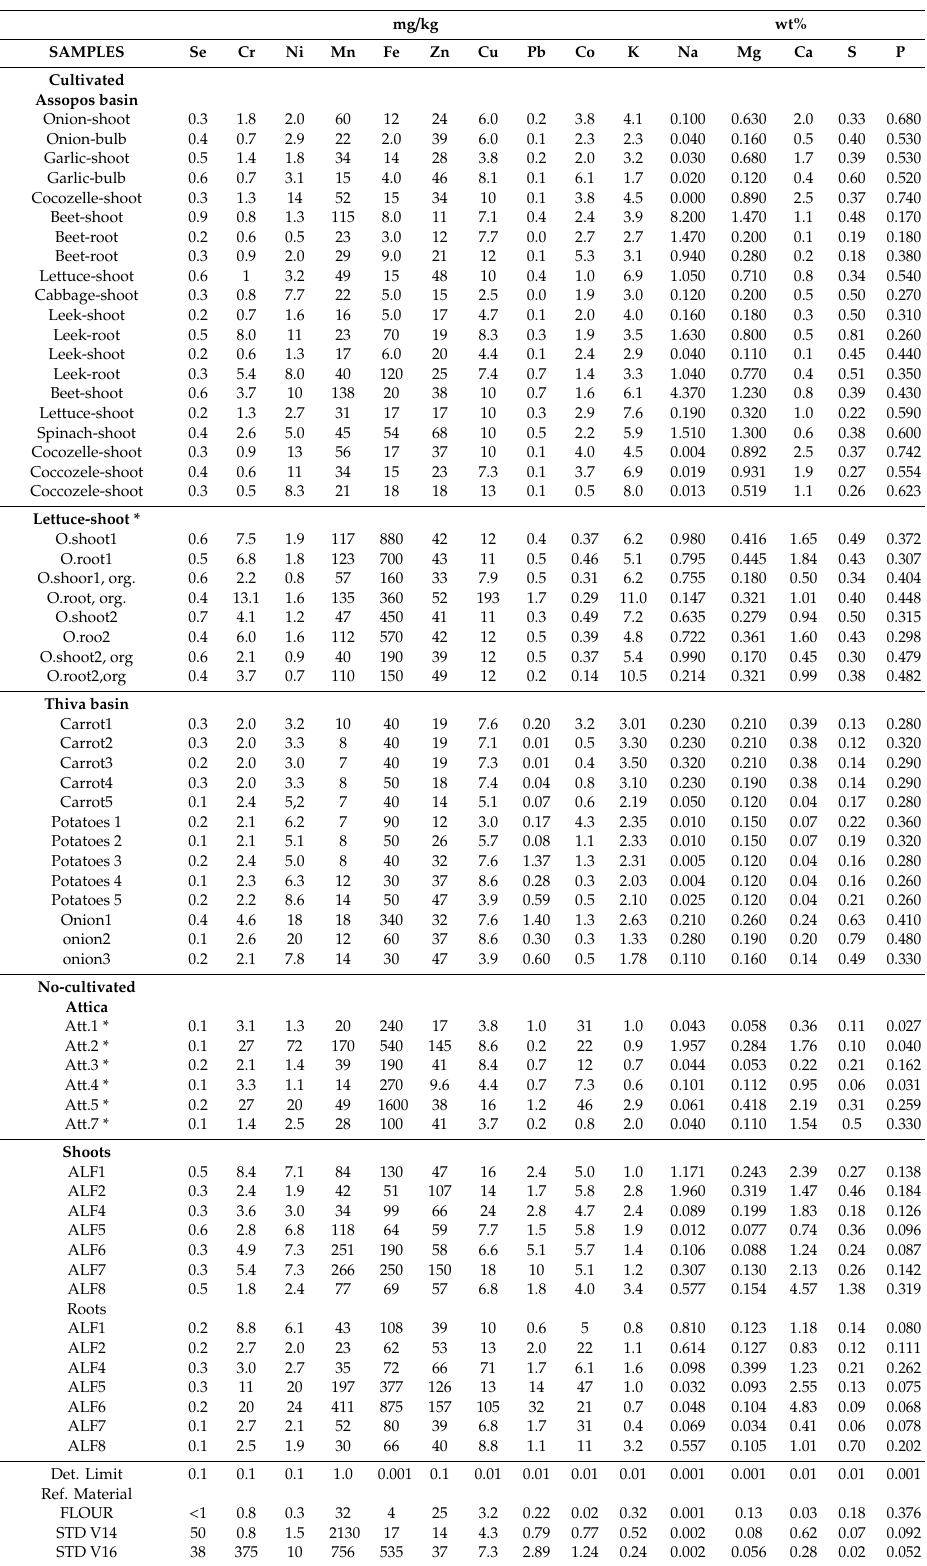
Table 2. Trace elements contents in cultivated and no-cultivated plants from Neogene Basins of Greece. (Present study *,